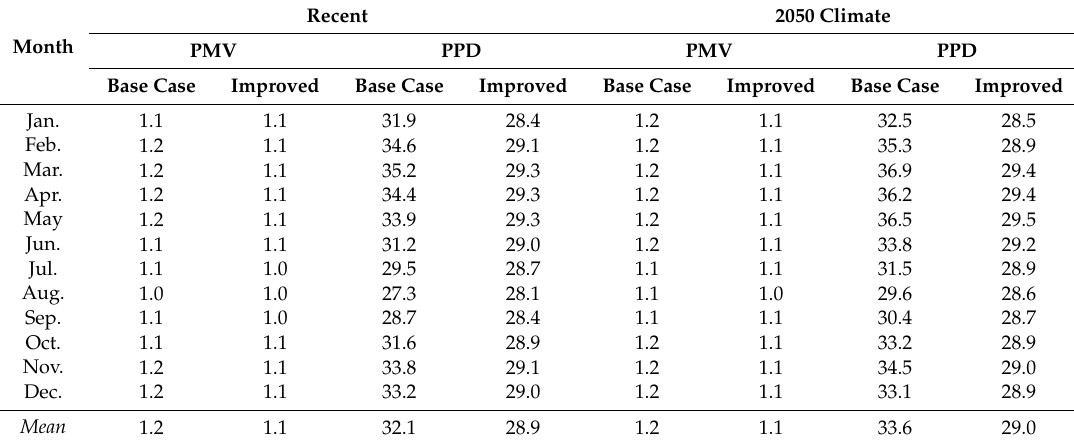
Table 14. PMV and PPD at 1% occupant for the building as-built and with improvement strategies when simulated with the recent and 2050 climate datasets for the Ashanti